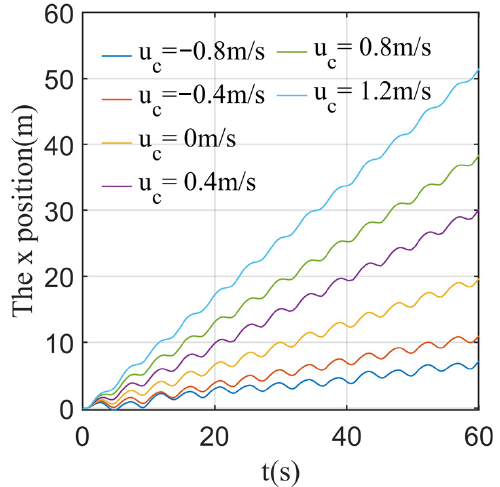
Figure 22. Comparison of the position of the surface float under different current